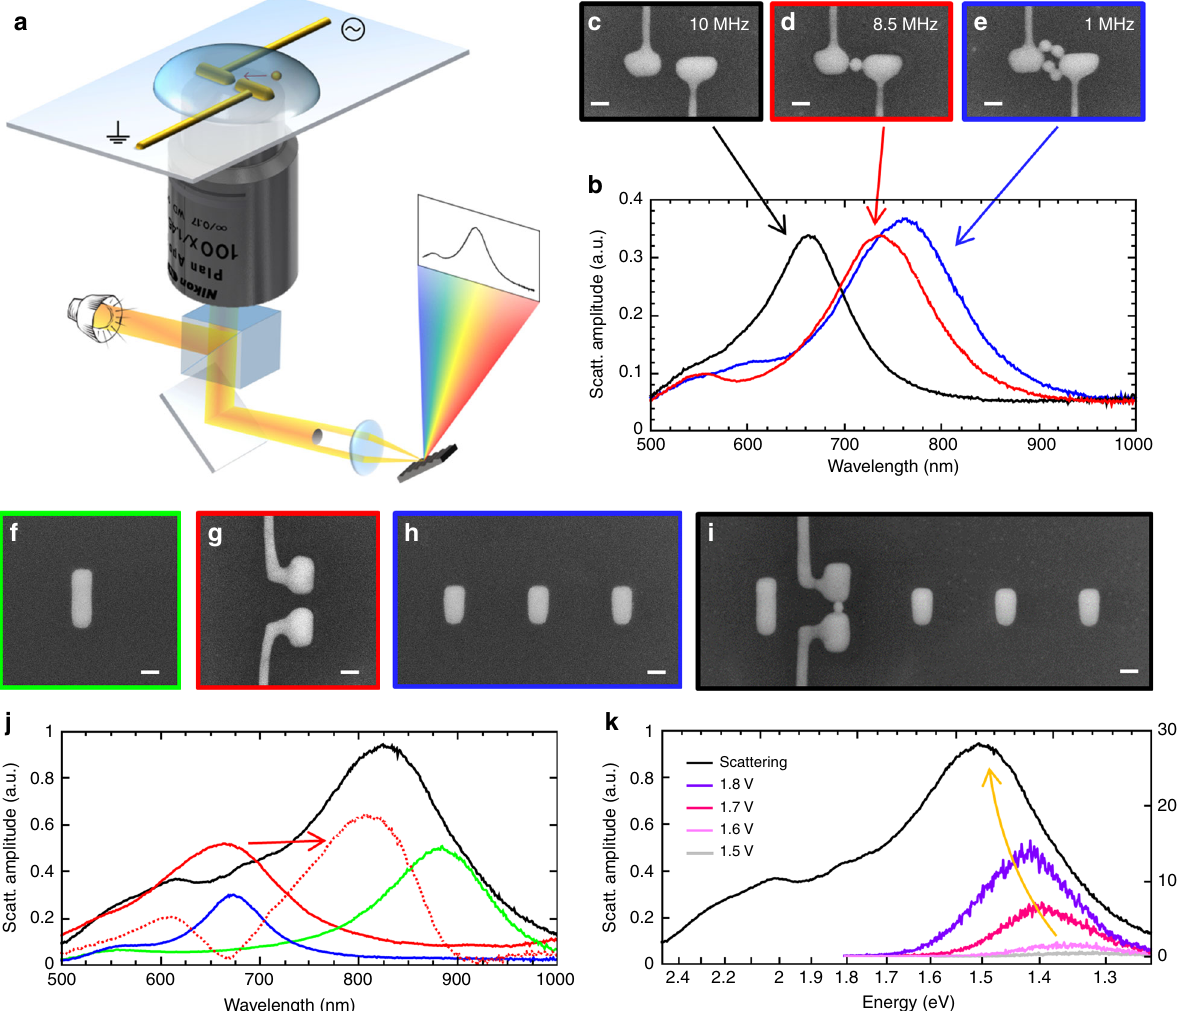
Fig. 2 Feedback-driven dielectrophoresis and characterization of the Yagi-Uda antennas. a Schematics of the DEP setup: while white-light dark- fi eld scattering spectra are continuously acquired, a high-frequency AC voltage is applied. As soon as a particle is deposited in the gap, the spectrum signi fi cantly redshifts as depicted in b and the voltage is subsequently switched off. c – e Associated SEM images for various DEP frequencies showing an optimum of one-particle attraction at 8.5 MHz. f – i SEM images and j associated spectra of a re fl ector (green), an unloaded feed element (red), the directors (blue) as well as a completely assembled Yagi-Uda antenna (black). The dotted red line in j is the delta of complete antenna minus the directors and re fl ector and corresponds to the feed element now loaded and redshifted due to the particle inside the gap. k Scattering spectrum vs energy of the Yagi-Uda antenna (same as in j ) and resulting electroluminescence (EL) spectra for various voltages. With growing voltages, the EL peak blueshifts and gets stronger as indicated by the yellow arrow (cf. ref. 7 ). Note the voltage drop-off is close to zero. Scale bars, 50